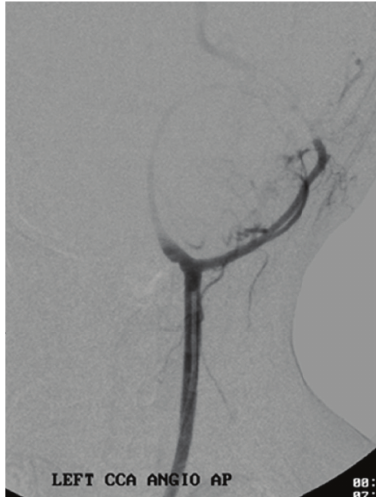
Figure 11: Digital subtraction angiography reveals hypovascular mass causing splaying of internal and external carotid arteries.